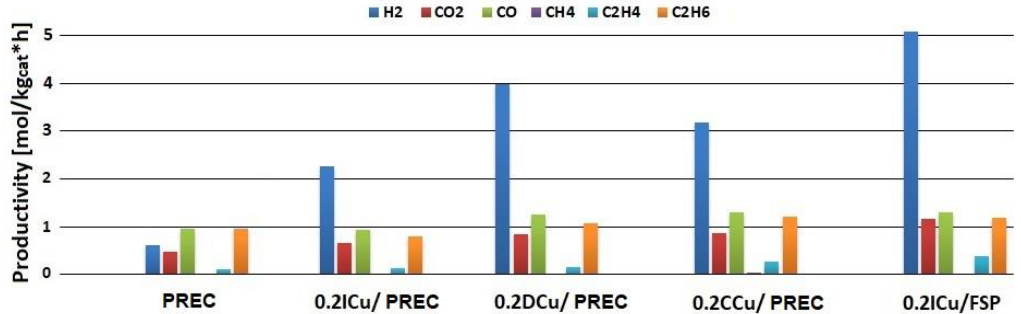
Figure 10. Productivity of various gas phase products with 0.2 wt % CuO loaded on PREC and FSP by different methods (I, D and C).